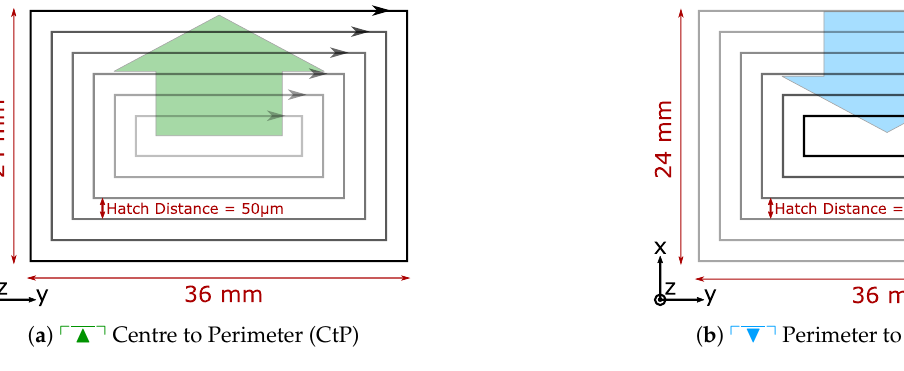
Figure 1. Schematics of both border fill scan strategies. ( a ) Describes the Centre to Parameter (CtP) strategy indicated by the green arrow, while ( b ) shows the Parameter to Centre (PtC) scan strategy indicated by the blue arrow. The black arrows show the direction of scan of the laser around each border fill